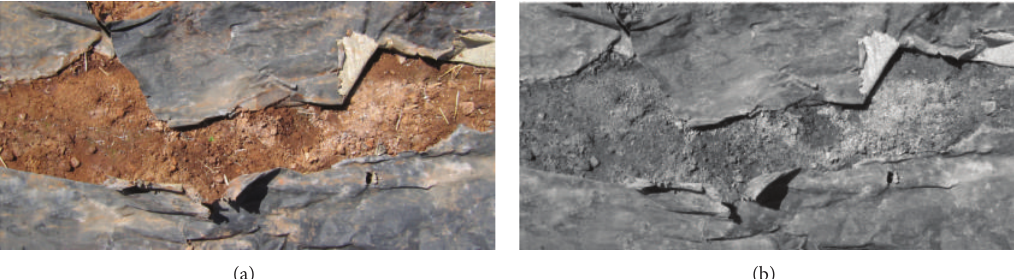
Figure 1: Image with mulch and soil 100 days after field implementation. (a) Original image in RGB color space; (b) grayscale image.